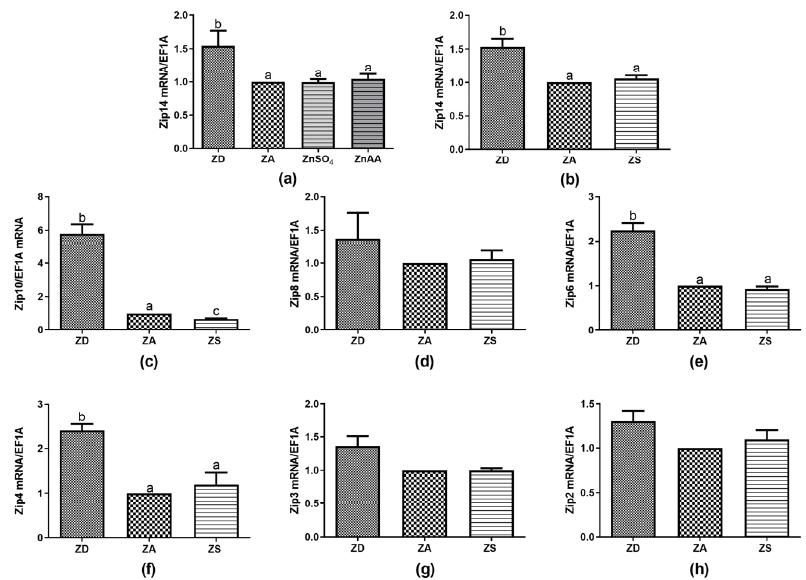
Figure 2. SF cells were cultured in CHELEX-treated medium, zinc adequate (ZA) medium or medium supplemented with ZnSO 4 (50 µ M) or ZnAA (50 µ M) for 7 days. Afterwards mRNA was isolated, used for measuring expression of Zip14 ( a , b ), Zip10 ( c ), Zip8 ( d ), Zip6 ( e ), Zip4 ( f ), Zip3 ( g ), Zip2 ( h ) mRNA expression and normalized to EF1A mRNA. Mean values + S.E.M. of at least n = 4 independent experiments are shown. Significantly different data sets as determined by one-way Anova and Tukey’s post hoc test do not share the same letters ( p < 0.05). Table 2. Reference Sequences (RefSeq) for all Zip and ZnT mRNAs that were below the detection limit in SF cells. Genes, where no homologous sequences were found for Asian sea bass are indicated as